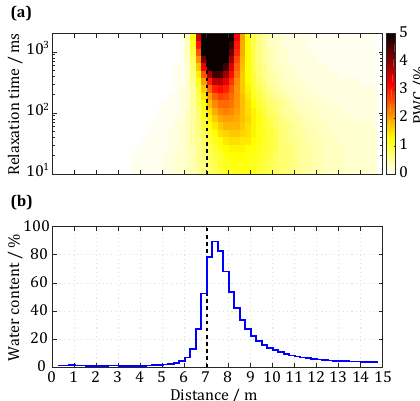
Figure 11. Inversion result of the field measured UMRS signal. ( a ) The distribution of inverted partial water content (PWC); ( b ) the total water content